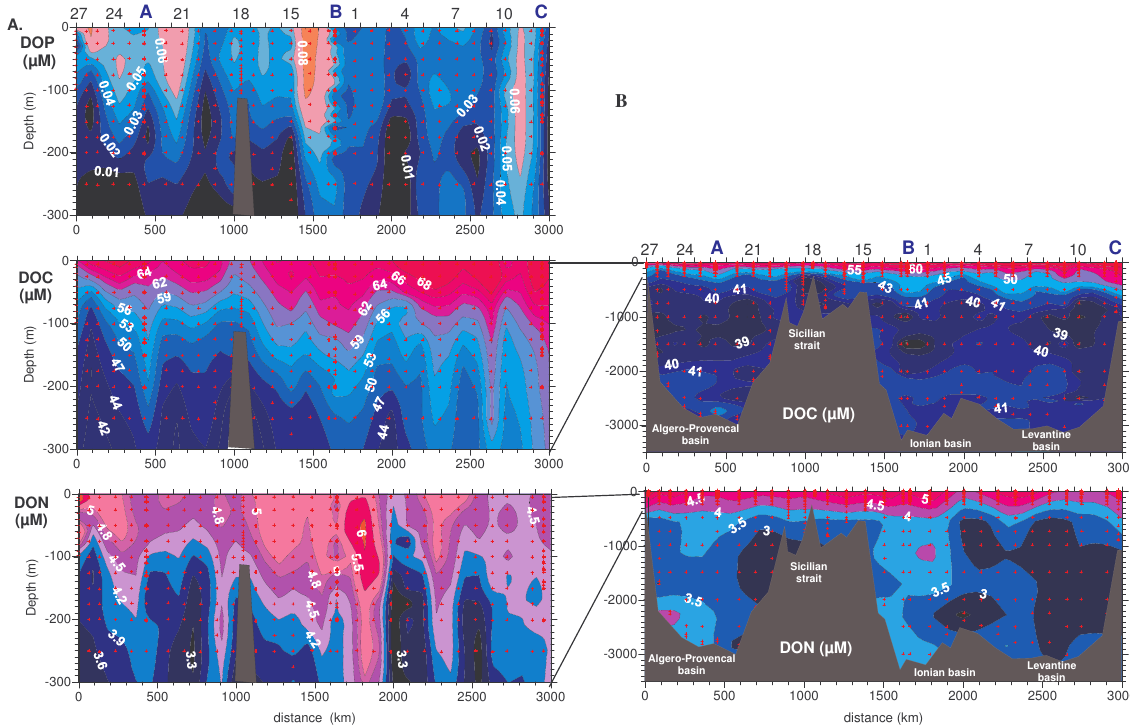
Fig. 5. Surface (0–300m) vertical sections of (A) dissolved organic phosphorus (DOP), carbon (DOC), and nitrogen (DON) along the BOUM transect. (B) as in (A) for the whole water column, except for DOP which is undetectable in deep water. On the top x-axis, the position of the stations is indicated.